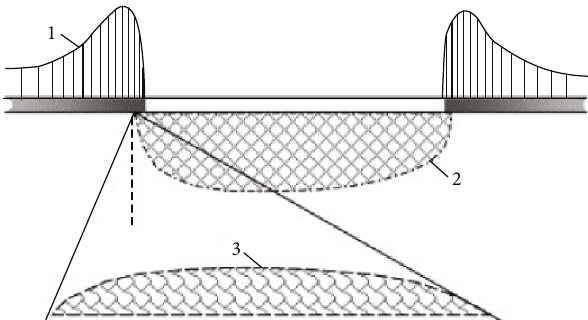
Figure 10: Fractured zone in the fl oor under longwall face (1: abutment pressure, 2: fractured zone, and 3: in situ hydraulic tensile fracture zone)